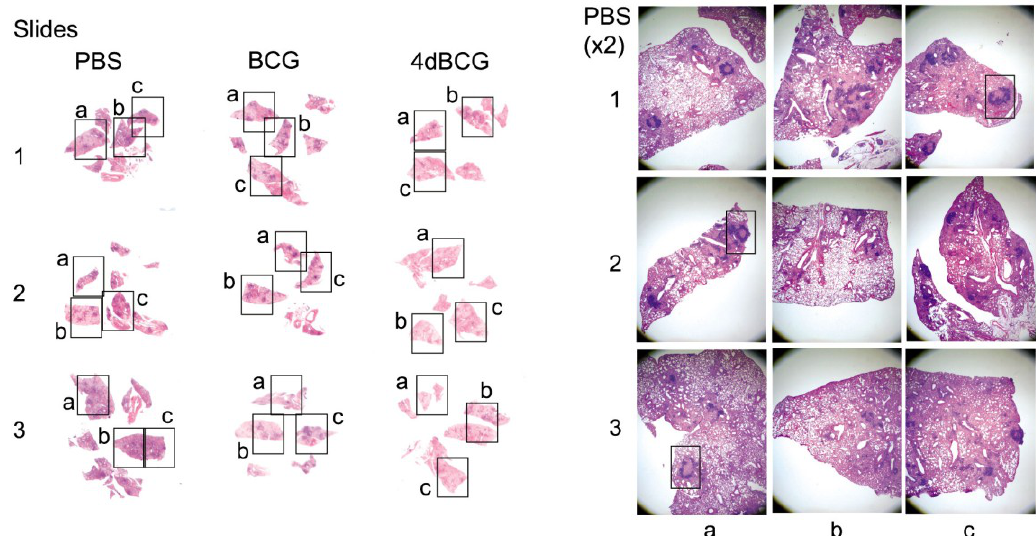
Figure 4. Low-power photomicrographs of sections of lung tissue. (Upper left panel, labeled ―Slides‖) Photographs of the microscope slides containing H&E-stained lung sections are shown from right lungs of three mice from each of the PBS, BCG, and 4dBCG vaccination arms at 8 weeks post-aerosol challenge with 100 cfu of M. tuberculosis strain Erdman S-1. Three rectangles are labeled a, b, and c and cover approximately 70–80% of the lung tissue on each slide. (Panels labeled ―PBS‖, ―BCG‖, and ―4dBCG‖) Three low-power photomicrographs of the lung tissue were taken through the 2× microscope objective and correspond to the three rectangles in each lung labeled a, b, and c in the ―slides‖ panel. Within these photomicrographs, the black rectangles highlight lymphohistiocytic nodules in relatively consolidated regions of lung tissue, which are enlarged further and displayed in Figure 5. The white rectangles in the 4dBCG group of mice outline lung tissue containing bronchus-associated lymphoid tissue (BALT) and are displayed in Figure